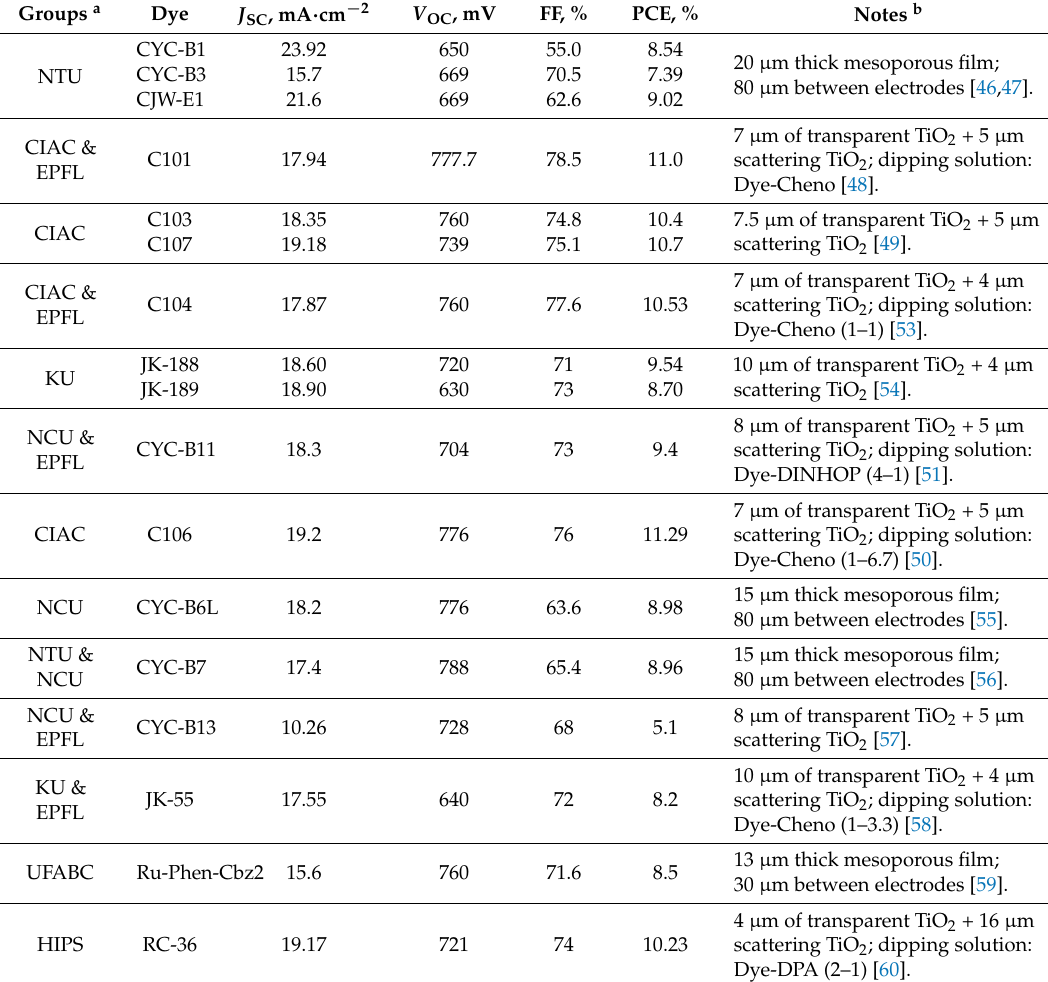
Table 1. Performances of selected tris -heteroleptic ruthenium complexes with isothiocyanate ligands and with thiophene-based substituents on the ancillary